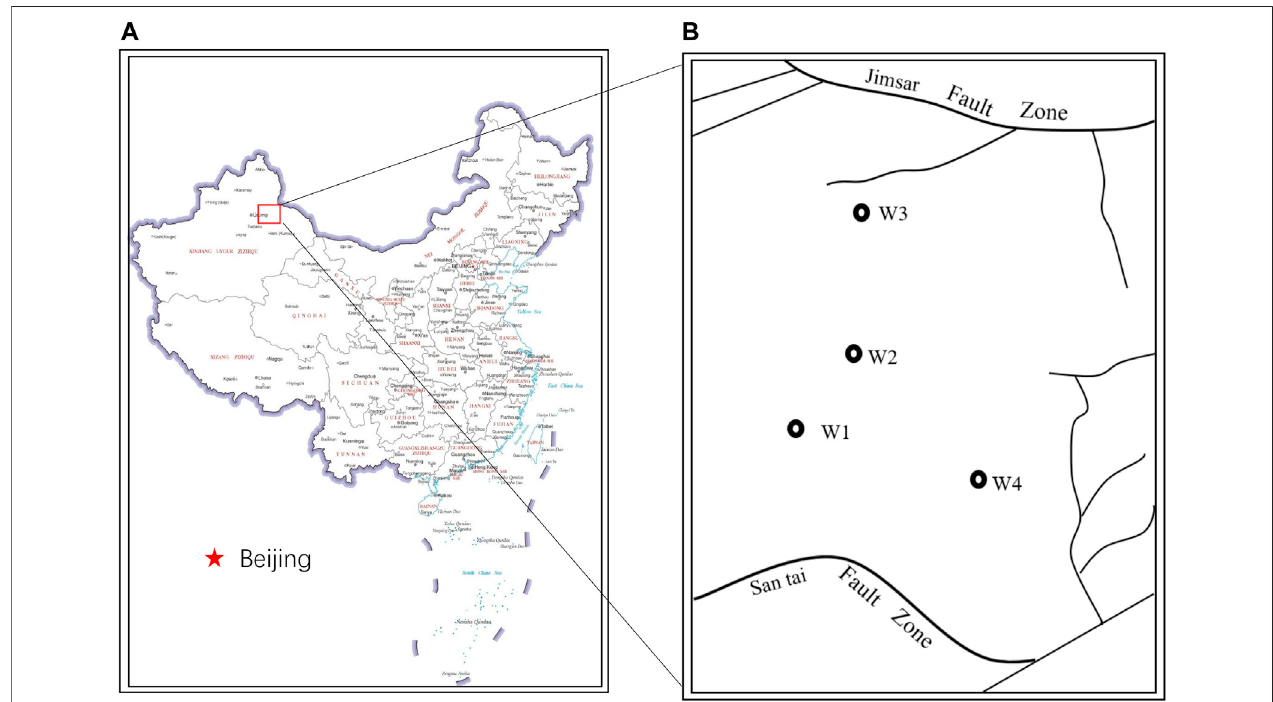
FIGURE 8 | (A) Location of Junggar Basin and (B) location of wells.